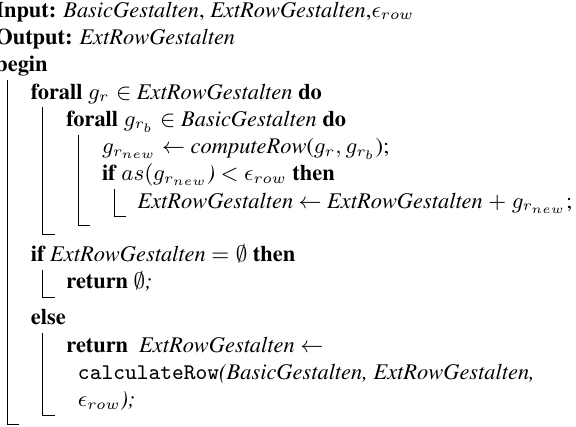
Algorithm 3: calculateRow (Searching max. meaningful rows)